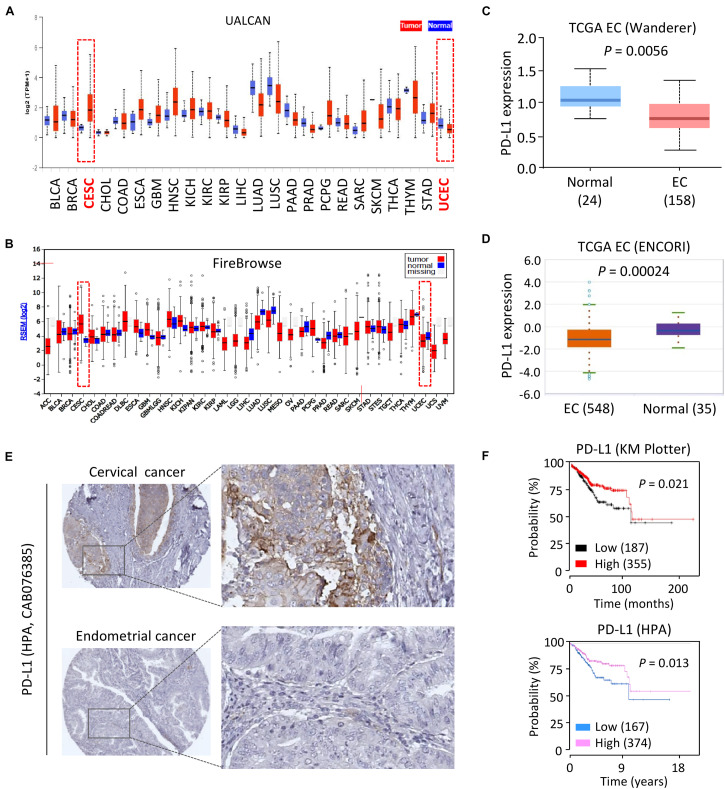
Downregulation of PD-L1 Correlates with Poor Survival in EC. (A,B) Analysis of PD-L1 expression in human cancer tissues and normal tissues using the TCGA data retrieved from the UALCAN database (A), and FireBrowse database (B). CESC: human cervical cancer; UCEC: human endometrial cancer. (C,D) PD-L1 mRNA expression in EC samples and normal samples was analyzed using the Wanderer database (C) and ENCORI database (D). (E) IHC staining for PD-L1 in human cervical cancer tissues and EC tissues with the same antibody (CAB076385, the HPA website) showed that high levels of PD-L1 were present in primary cervical cancer tissues. In contrast, PD-L1 was negatively or weakly stained in most EC tissues. (F) The probability of overall survival in EC patients expressing high or low PD-L1 levels was assessed using the KM plotter database (upper) and the HPA database (bottom). Red indicates CESC (human cervical cancer) or UCEC (human endometrial cancer).